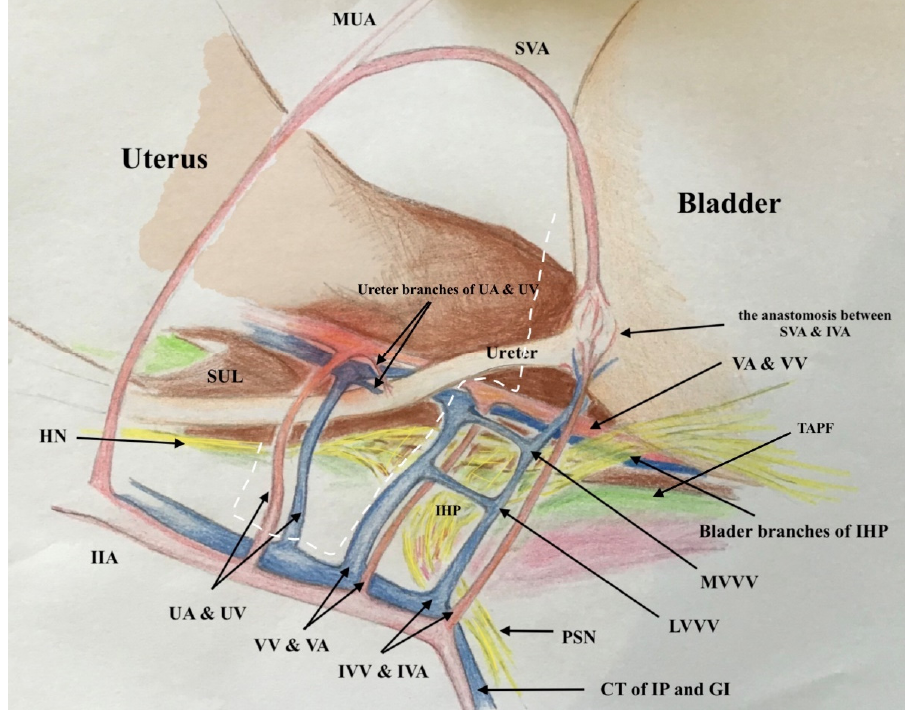
Figure 8. The graphic explanation of type III radical hysterectomy according to Muallem classifica- tion; the dotted white line shows the resection line at the distal aspects of ventral, lateral and dorsal parametrium and at the proximal aspects of ventral, lateral and dorsal